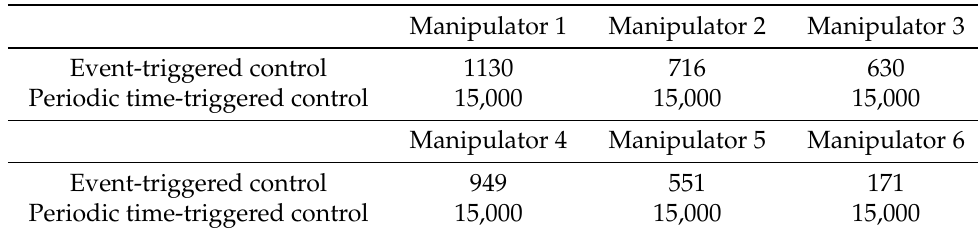
Figure 17. Time − triggered control input u 6 . Table 1. The number of updates for controls under event-triggered controllers and periodic time- triggered